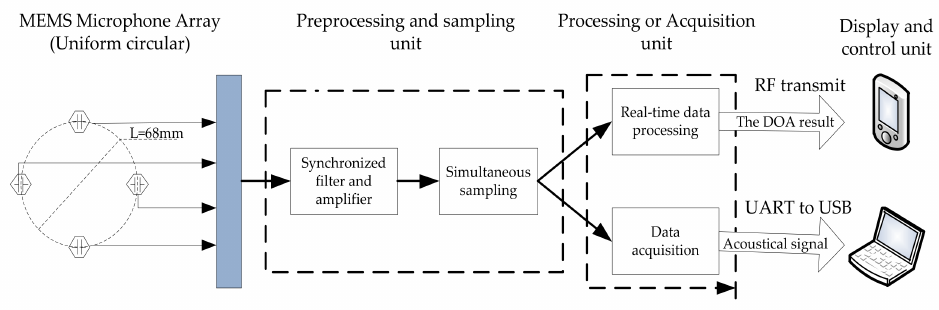
Figure 9. Block diagram of the MEMS Microphone Array